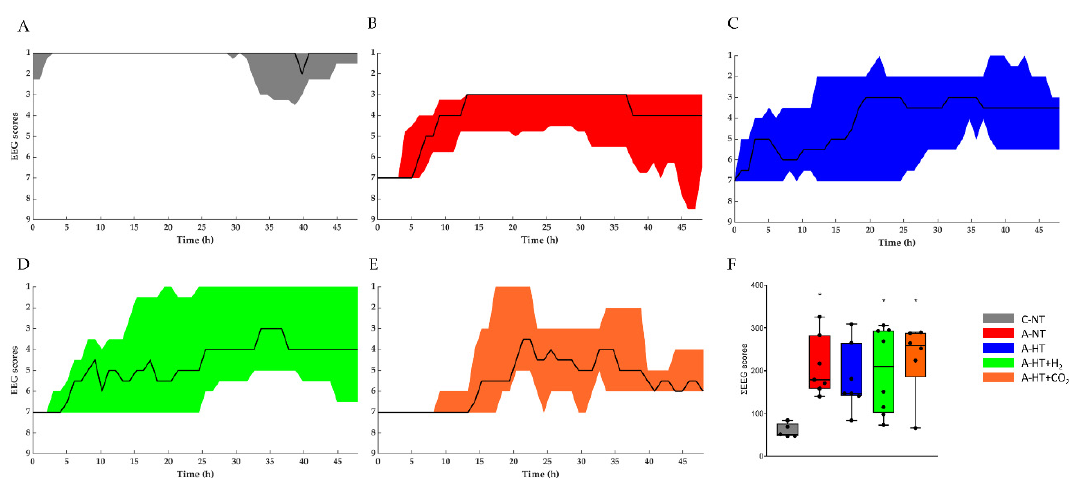
Figure 5. The EEG recordings were scored using a previously published [14] amplitude-based scoring system (Table S1), where higher scores represent progressive deterioration of electrical activity. Experimental groups: control-normothermia (C-NT), asphyxia-normothermia (A-NT), asphyxia-hypothermia (A-HT), A-HT supplemented with H 2 (A-HT + H 2 ) or CO 2 (A-HT + CO 2 ), respectively. ( A – E ): The black line shows the median values whereas the shaded area represents the 25th-75th interquartile range. C-NT animals were characterized by continuous EEG activity and low EEG scores during the entire experiment, whereas asphyxia induced isoelectric EEG that was followed by slow regeneration of electrical activity in all experimental groups in the observation period. There were no significant di ff erences among the treatment groups at any time points; however, the large intra-individual variability can be appreciated. ( F ): The sum of EEG scores during the observation period in the experimental groups. The black line represents the median, the box the interquartile range, the whiskers the 10th-90th percentiles, the bullets the raw values. The summated EEG scores were significantly higher in the A-NT, A-HT + H 2 , and A-HT + CO 2 asphyxia groups compared to the C-NT (* p < 0.05) group, but this was not the cause in the A-HT group, suggesting that the best outcome was found in these animals.